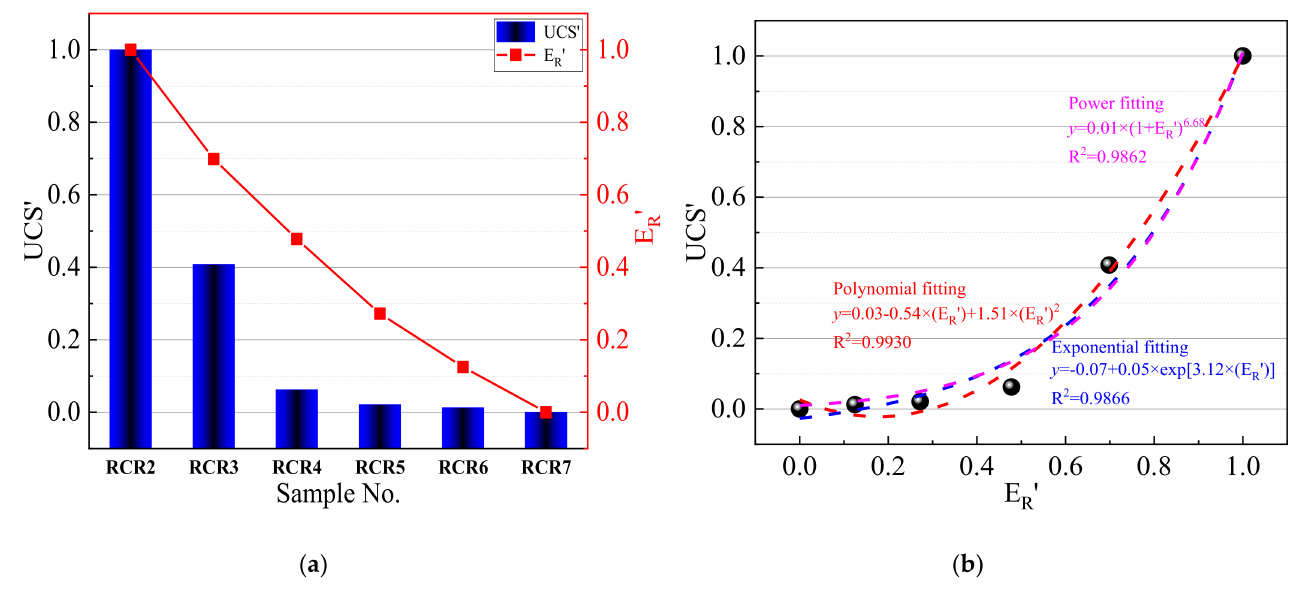
Figure 16. Relationship between ( UCS ’ and E R ’ of RCF